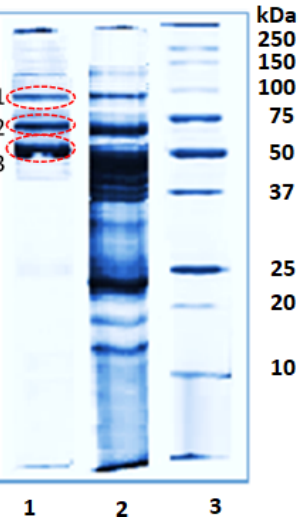
Figure 1. Fractions from R. venosa hemolymph analyzed by 12.0% SDS-PAGE visualized by staining with Coomassie G-250: position (1) with Mw 50–100 kDa; (2) with Mw 10–100 kDa; (3) molecular weights of standard proteins from Bio-rad.